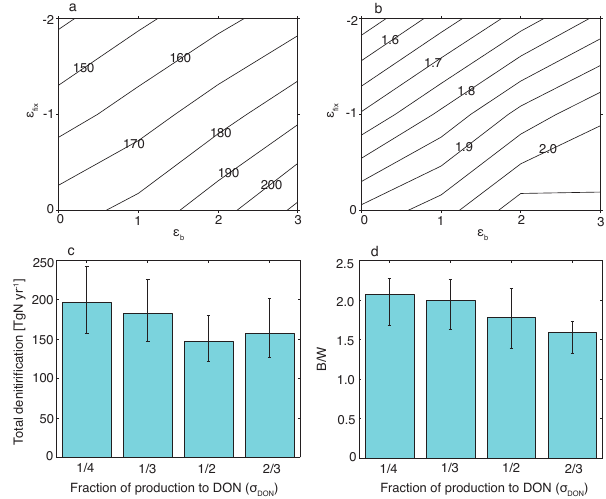
Fig. 7. (a) Globally-integrated denitrification (TgN yr − 1 ) and (b) ratio of benthic ( B ) to water-column ( W ) denitrification as a function of isotopic enrichment factors for nitrogen fixation ( (cid:15) fix ) and benthic denitrification ( (cid:15) b ). (c) Globally integrated denitrification and (d) B/W as a function of the fraction of organic matter produc- tion routed to the dissolved organic nitrogen (DON) pool. Results in (a) and (b) show mean values from all model solutions, and results in (c) and (d) show median (filled bars) and range (error bars) from all model